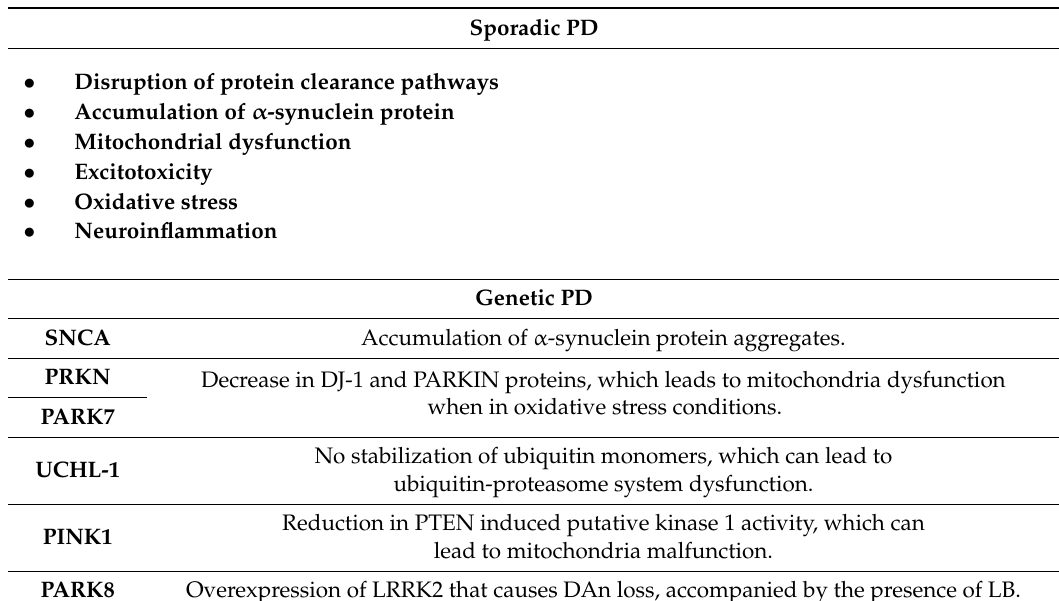
Table 1. Sporadic and genetic types of Parkinson’s Disease